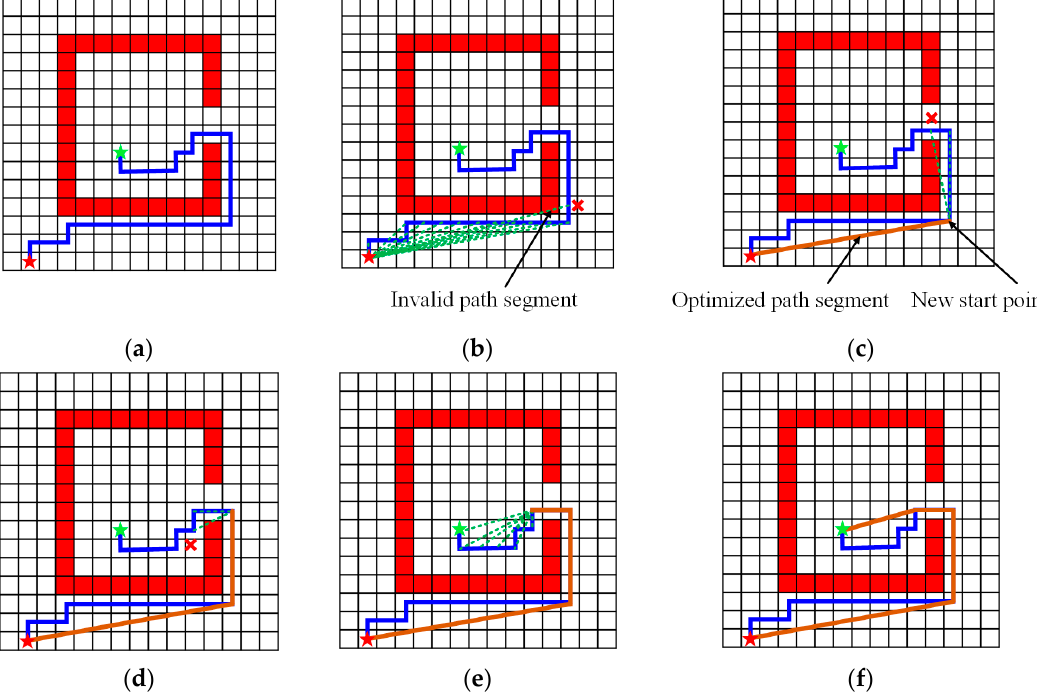
Figure 12. A 2D example of the path optimization process. ( a ) The projected back path (in blue) and the obstacle (in red) in C- space. ( b ) Connecting the start cell (red star) and temporary target cell (green star) until the path conflicts with the obstacle. ( c ) Taking the last cell before the temporary target cell as the new start cell and repeating the step ( b ). ( d , e ) Repeating the above two steps until the temporary target cell reaches the final target cell. ( f ) The final optimized trajectory (in orange). Algorithm 2. Trajectory optimization